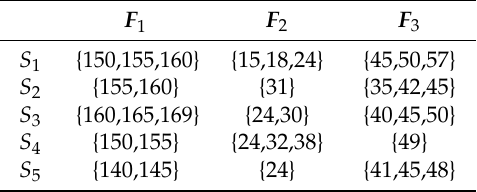
Table 1. The actual measured value after screening.